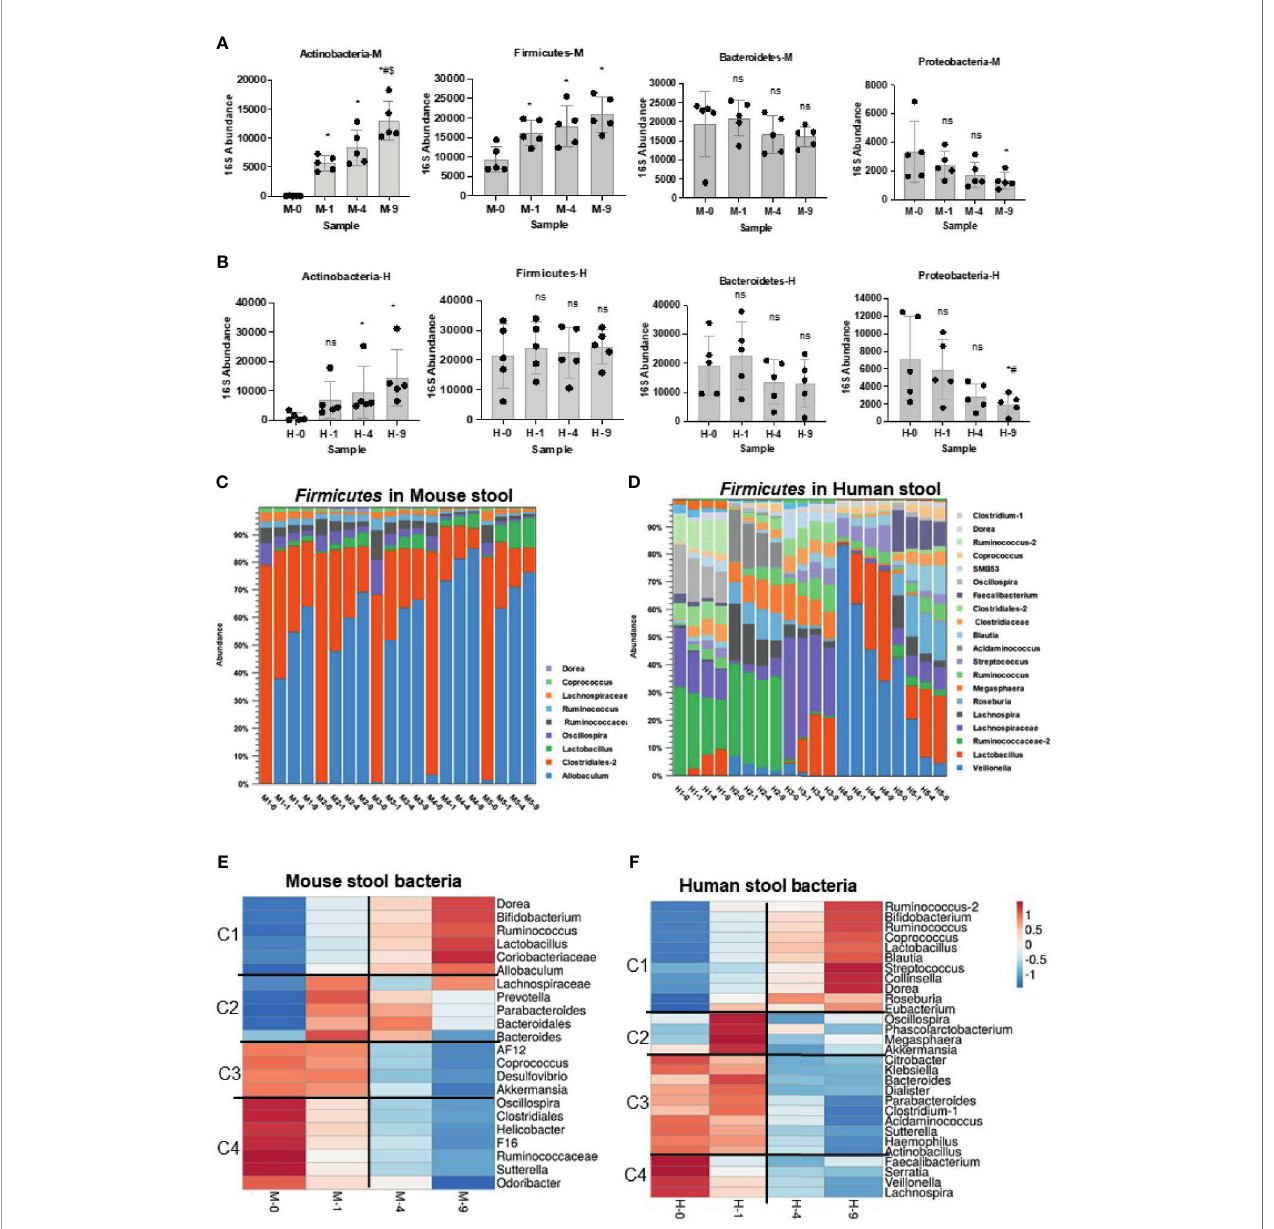
FIGURE 2 | Impact of bead-beating on Phylum- and Genus -level recovery of gut microbiota. Panel (A) Relative abundance of Actinobacteria, Firmicutes, Bacteroidetes, and Proteobacteria at four bead-beating conditions inmouse stool. Panel (B) shows the relative abundance of Actinobacteria, Firmicutes, Bacteroidetes, and Proteobacteria at four bead-beating conditions in humanstool.Each blackdot represents anindividual stool sample. Bar plots show relative 16S abundance on the y-axisand samples on the x-axis. Panels (C) shows detected abundances of various Firmicutes in mouse stool.Panel (D) shows abundances of Firmicutes inhumanstool. Panel (E) Heatmap shows four clusters of mouse stool bacteria that differ in their abundances at various bead-beating conditions. Panel (F) Heatmap shows four clusters of humanstool bacteriathat differ in theirabundances at various bead-beating conditions. These clusters were generatedusing ClustVis , a web toolfor visualizing clustering of multivariate data (BETA) (Metsalu and Vilo, 2015). Blue and red color in the heatmap indicate lowest or highest abundance, respectively. Statisticalp-values are denoted with*, # and $ represent comparison of unbeaten sample data with 1-, 4-, and 9-min beaten samples, respectively. ns, not signi fi